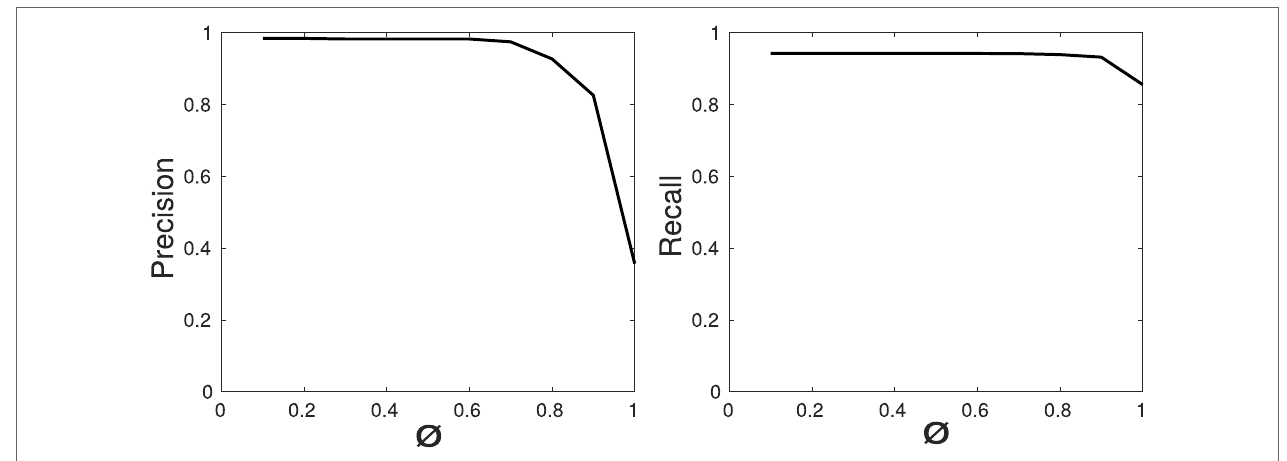
FigUre 12 | Robustness evaluation: precision and recall curves for the video sequences of the sessions performed by the subjects